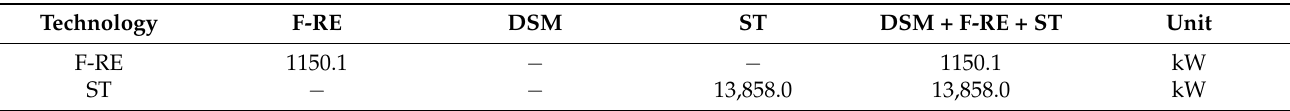
Table 9. Installed capacity in kW in the balancing technology scenarios.